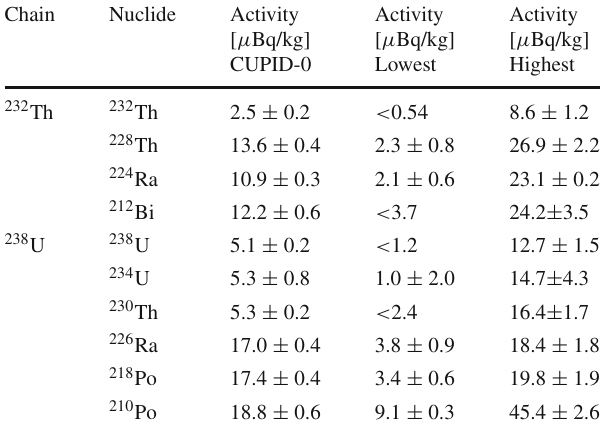
Fig. 28 Total alpha energy spectrum of all detectors Table5 Evaluatedinternal α radioactivecontaminationfortheCUPID- 0 detector. The values reported refer to the overall detector radiopurity (CUPID-0), the lowest (Best) and highest (Worst) measured contami- nation in a single crystal. 210 Po values refers to the sum of bulk and surface contaminations. Limits are evaluated at 90%